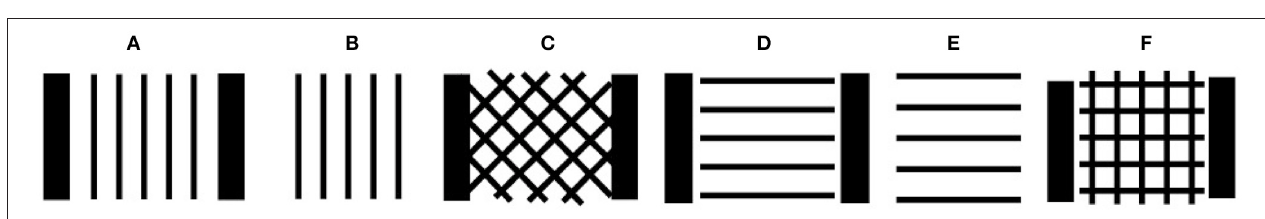
FIGURE 4 | Six layouts for printing dog-bone specimens: (A) 90 ◦ with support walls, (B) 90 ◦ without support walls, (C) ± 45 ◦ with support walls, (D) 0 ◦ with support walls, (E) 0 ◦ without support walls, and (F) 0 ◦ / 90 ◦ with support walls.